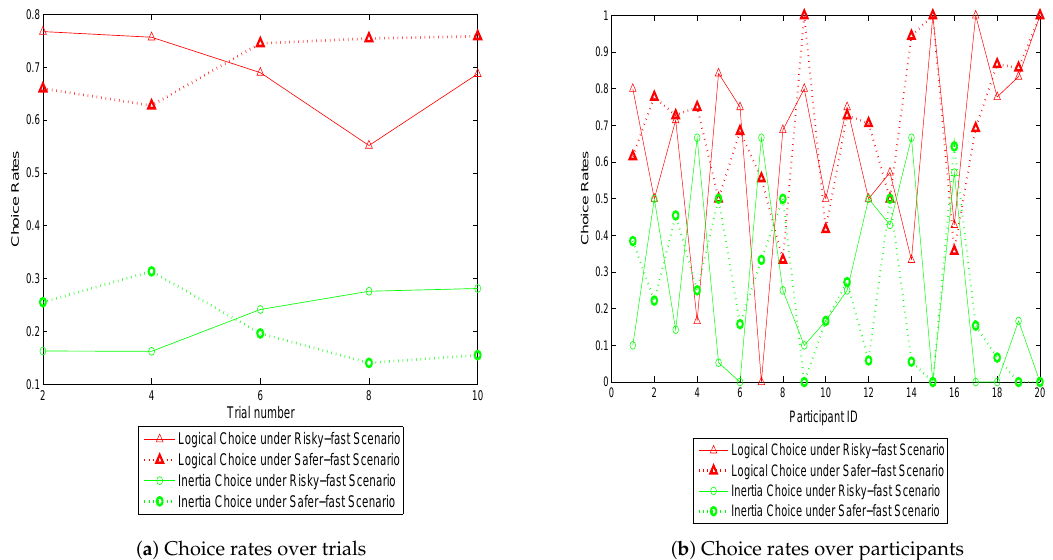
Figure 6. Choice rates with risky-fast scenario vs. safer-fast